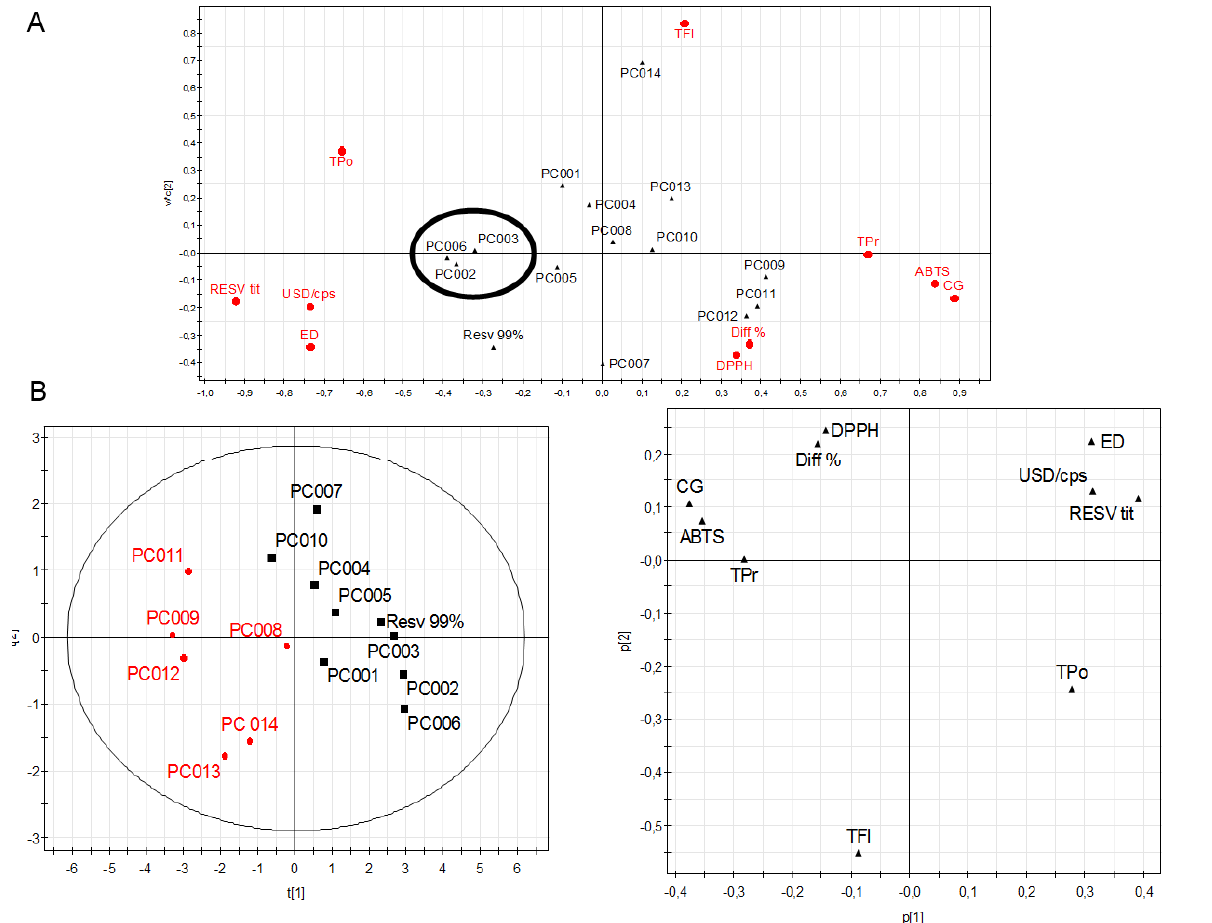
Figure 3. Score plot for PLS model and discriminant